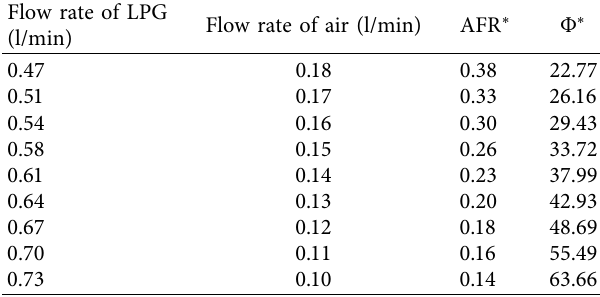
Table 1: The mixture of Saudi LPG/air for the Bunsen